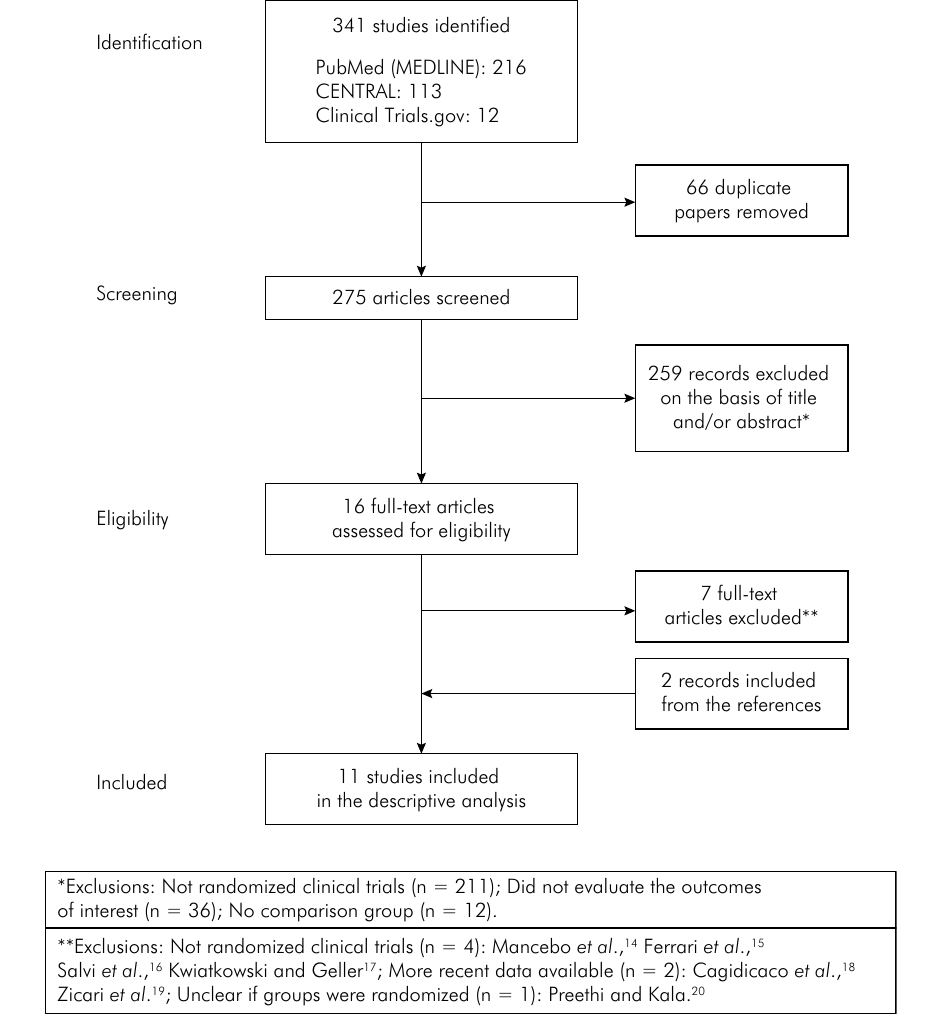
Figure 1. Flow chart depicting the selection of studies for review according to PRISMA